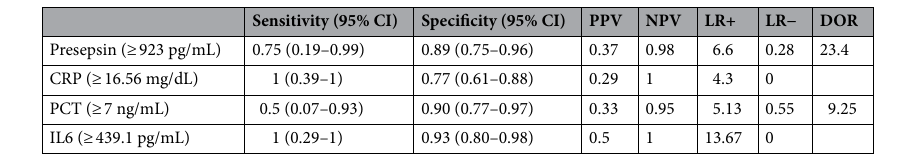
Table 4. Sensitivity, specificity, positive predictive value (PPV), negative predictive value (NPV), positive likelihood ratio (LR +), negative likelihood ratio (LR-), diagnostic odds ratio in predicting unfavorable outcome at T1. CRP: C reactive protein; IL6: interleukin 6; PCT: procalcitonin.